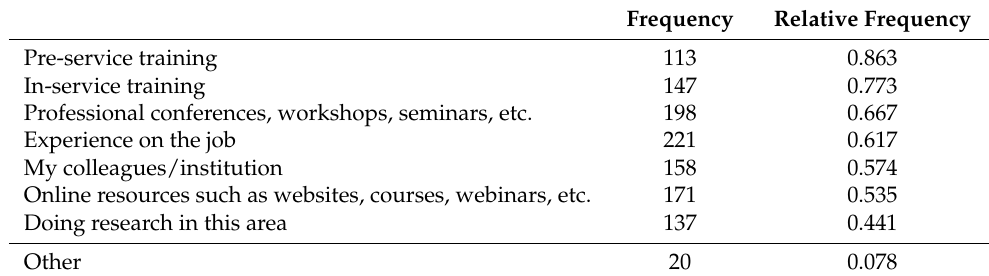
Table 1. The educators’ assessment